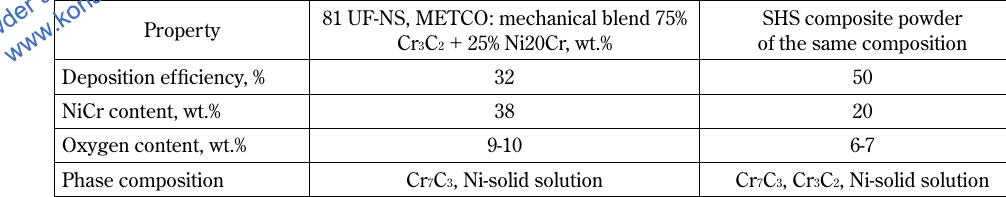
Table 2 Erosion resistance of TS coatings under 0.05-0.20 mm SiO 2 erodent impact (16 g/mm 2 , 60 m/s, 90 ° ) Material (Composition in